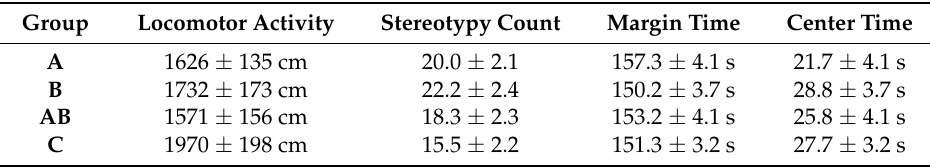
Table 1. Motor Activity at PND 35 in MAO-inhibited and Control